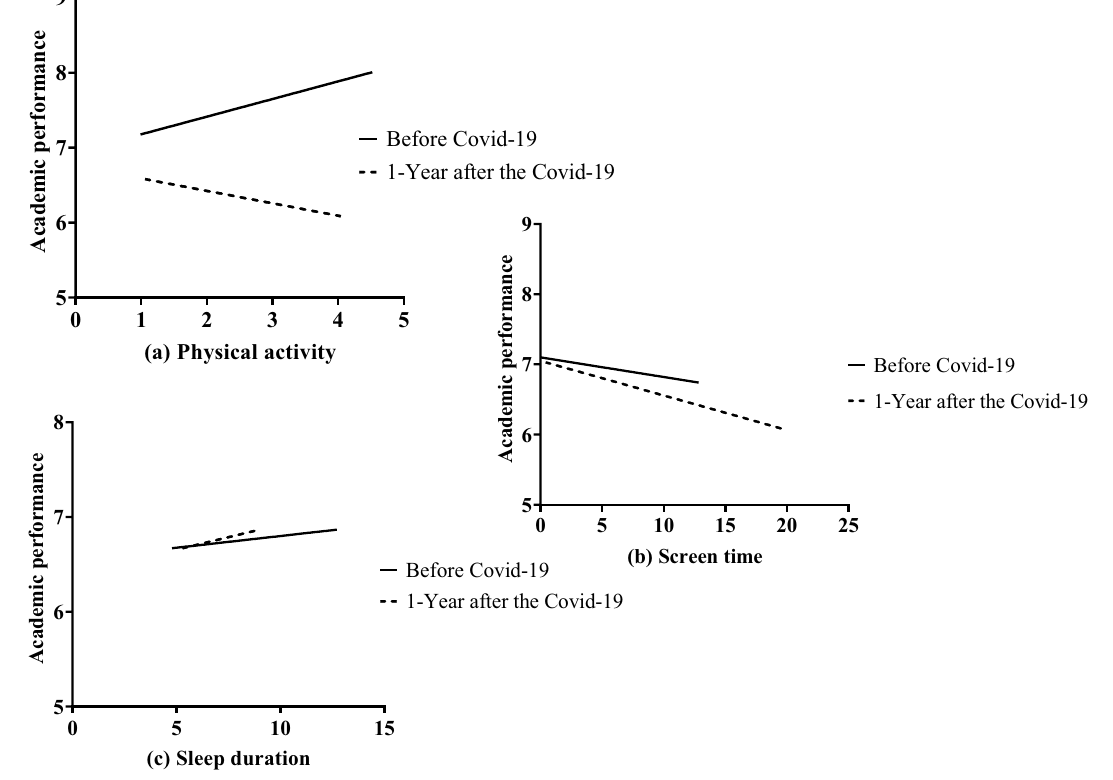
Figure 2. Independent association between physical activity, recreational screen time and sleep duration with academic performance before and 1 year after